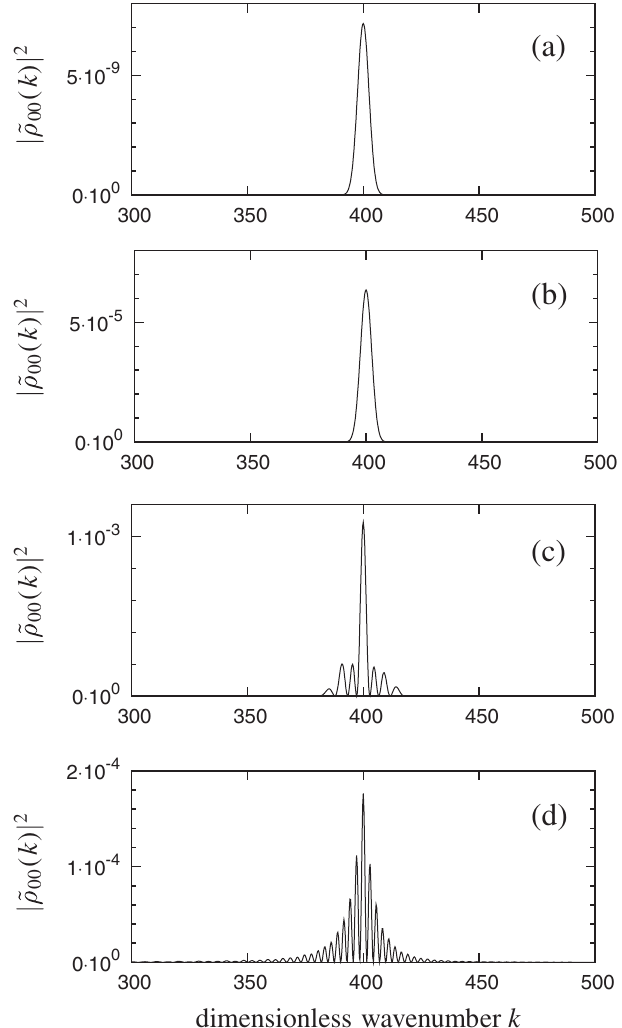
FIG. 11. Deformation of the form factor (and the emission spectrum) predicted at very high powers [numerical computation using Eq. (A13)]. (a) w 0 ¼ 0 : 1 , (b) w 0 ¼ 1 , (c) w 0 ¼ 10 , (d) w 0 ¼ 100 . Other parameters are k (cid:1) 0 : 000 53 , r 52 ¼ 0 : 0021 , and r 56 ¼ (cid:1) 0 : 0029